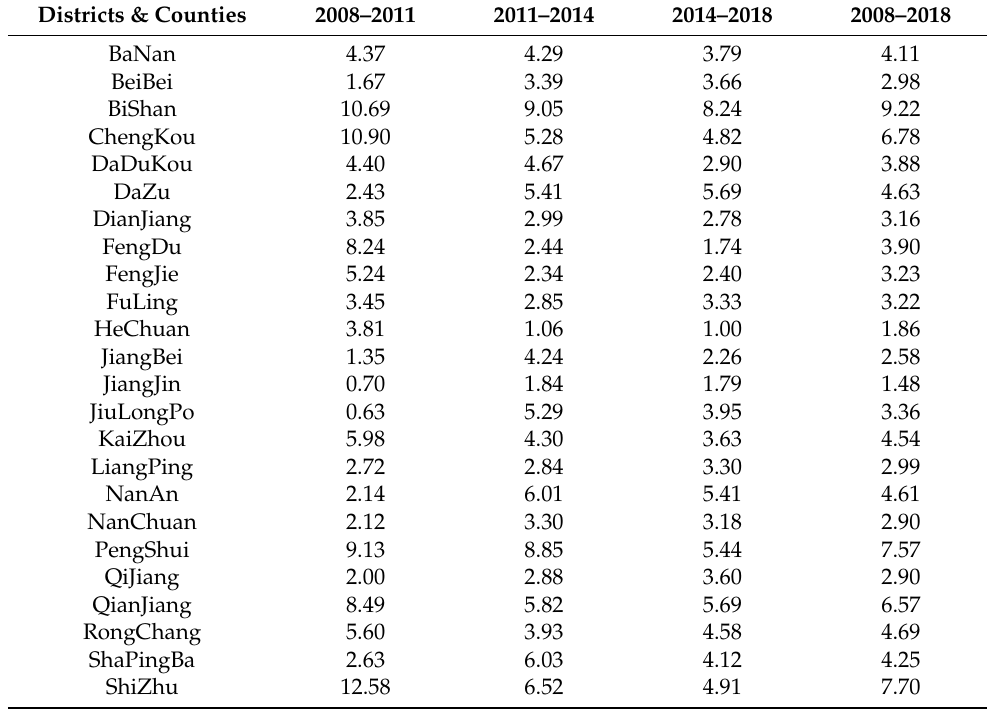
Table 3. Annual average growth rate of Chongqing’s urban population (%). Districts &